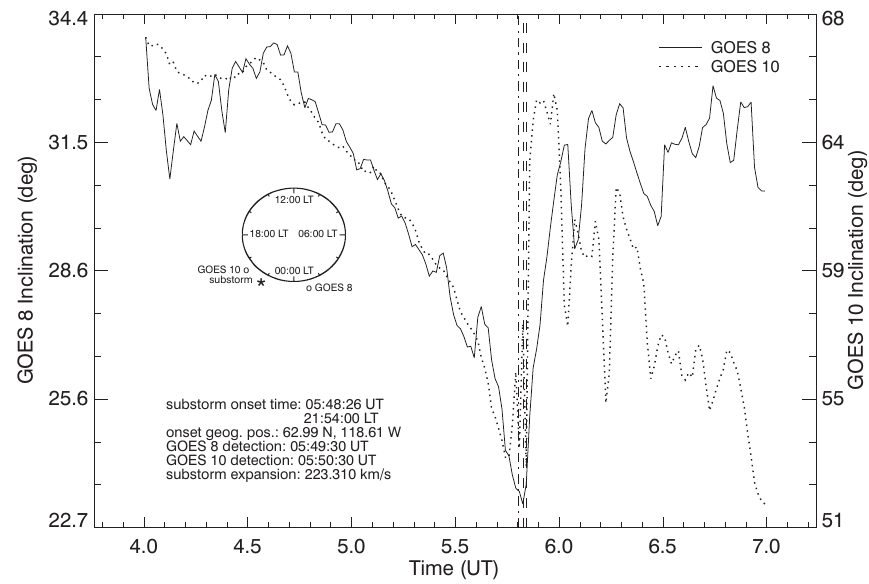
Fig. 5. Magnetic inclination calculated from GOES data showing dipolarization signatures of a substorm event on 18 July